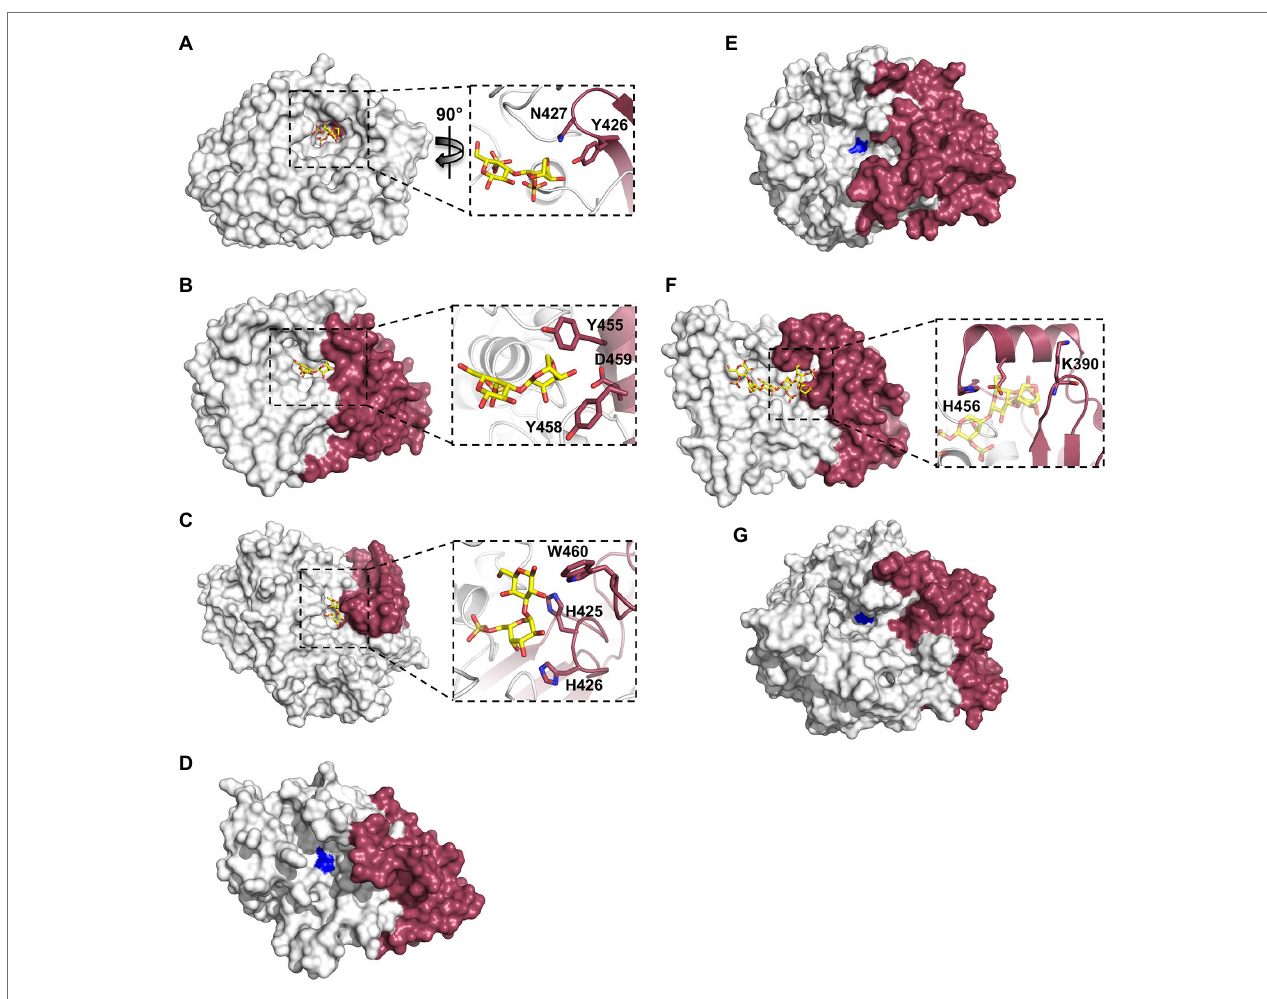
FIGURE 5 | X-ray crystal structures of marine carbohydrate-specific sulfatases highlighting the importance of the C-terminal sub-domain. The X-ray crystal structure showing the solvent accessible surface of PfS1_NC C84S in complex with an ι -carrageenan disaccharide [PDB ID: 6PT6, Hettle et al. (2019)] (A) , PfS1_19BC77S in complex with a κ -carrageenan disaccharide [PDB ID: 6PSM, Hettle et al. (2019)] (B) , BuS1_11 S80 in complex with neoporphyrabiose [PDB ID: 7LJ2, Robb et al. (2022)] (C) , P36_S1_25 [PDB ID: 6HR5, Reisky et al. (2019)] (D) , PsFuc1 [PDB ID: 7AJ0, Mikkelsen et al. (2021)] (E) , PsS1_19A C78S in complex with a κ - ι - κ -carrageenan hexasaccharide [PDB ID: 6B0J, Hettle et al. (2018)] (F) and P18_S1_7 [PDB ID: 6HHM, Reisky et al. (2019)] (G) . In all panels, the N-terminal sub-domain is coloured white, the C-terminal sub-domain is coloured ruby. In panels (A–F) inset, oligosaccharides coloured yellow sticks, sulfatases are shown in cartoon representation with the same colouring as the solvent accessible surface, C-terminal sub-domain residues involved in binding are shown as ruby sticks. In panels (D) , (E) , (G) , the site of the catalytic Fgly is coloured